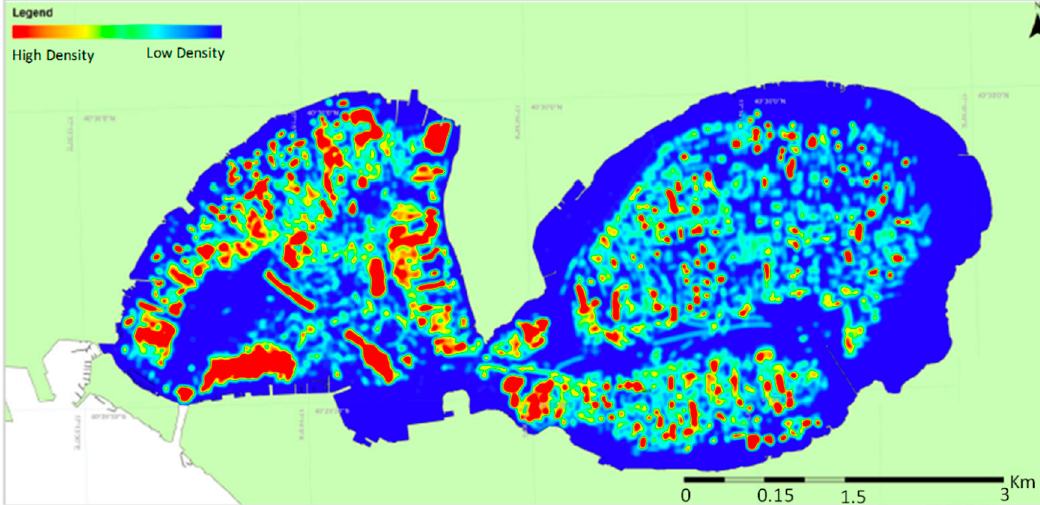
Figure 13. Map of the distribution of anthropogenic impacts in the seafloor [55].